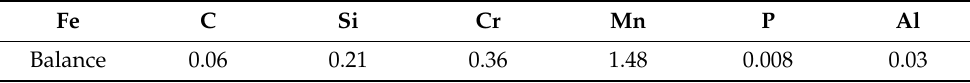
Table 1. Compositions and concentration (wt.%) of the steel. Fe C Si Cr Mn P Al